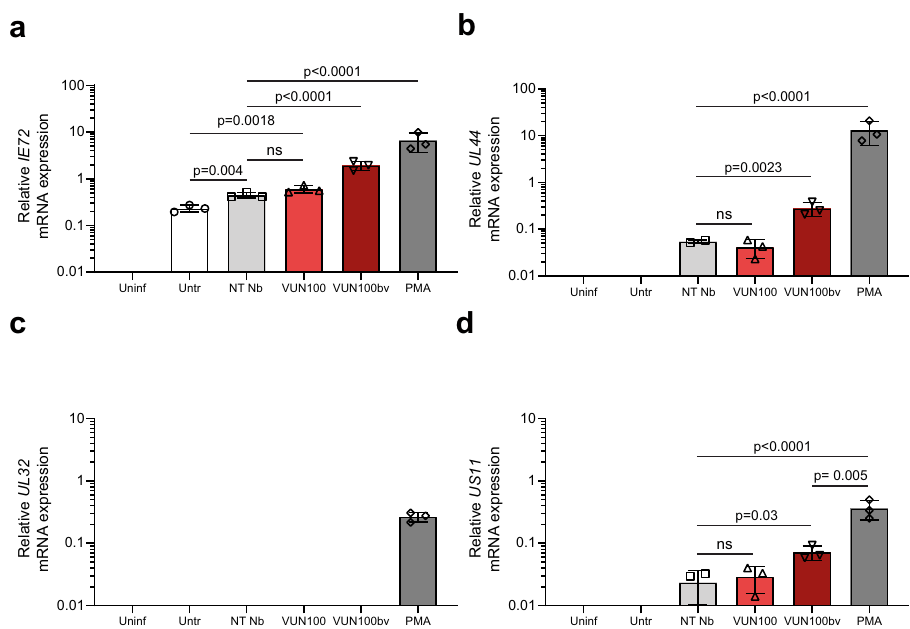
Fig. 3 VUN100bv increases immediate-early, early and late gene but no true late gene expression. CD14 + monocytes were left uninfected (Uninf) or infected with HCMV IE2-eYFP. Infected monocytes were left untreated (Untr), treated with a non-targeting nanobody (NT Nb), VUN100, VUN100bv, or pre-treated with 20 ng/ml PMA before infection (PMA). Six days post infection, RNA was isolated and IE72 ( a ), UL44 ( b ), UL32 ( c ), and US11 ( d ) gene expression was measured by RT-qPCR. Representative fi gures, showing technical replicates, from two biological replicates are shown. All data are plotted as mean ± S.D. For all fi gures, statistical analyses were performed using unpaired one-way ANOVA with Tukey ’ s multiple comparison test. ns, p > 0.05. Source data are provided as a Source Data fi